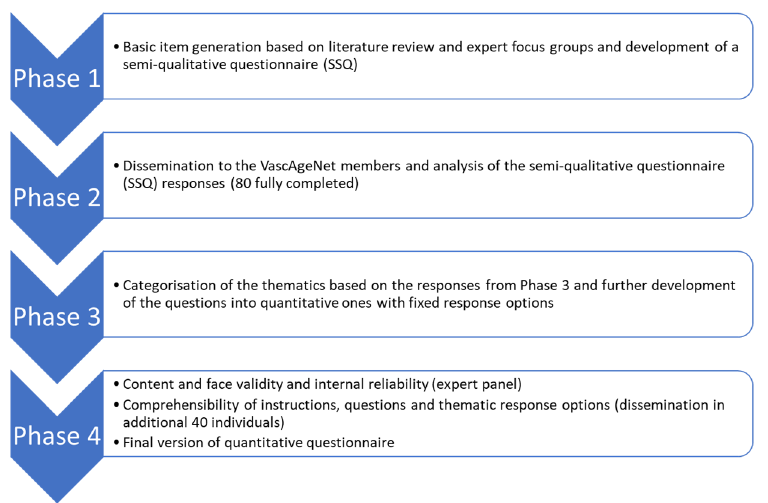
Figure 1. Flow chart of the four development phases of the questionnaire. Phase 1: Basic item generation and development of a semi-qualitative